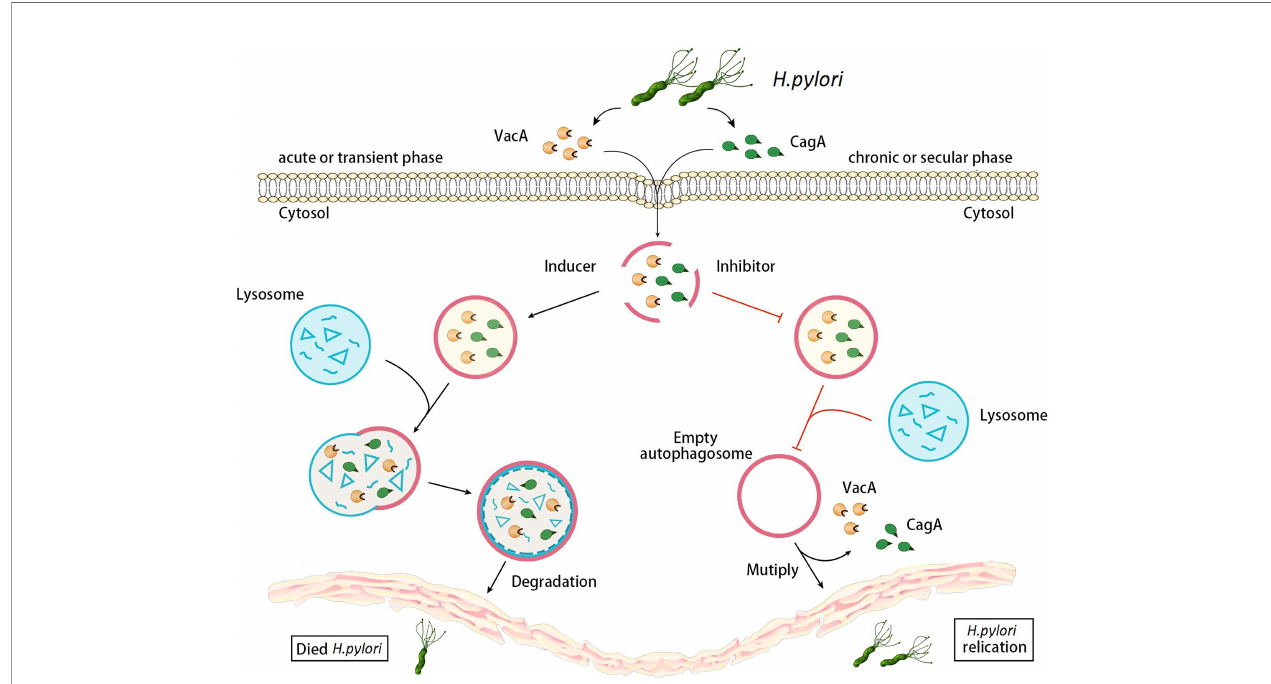
FIGURE 1 | Changes of autophagy in gastric epithelial cells during different stages of H. pylori infection. During the acute stage of H. pylori infection, VacA and CagA secreted by H. pylori infection induce autophagy, and then autophagy degrades VacA and CagA. However, during chronic H. pylori infections, VacA and CagA inhibit autophagy, limiting the degradation of VacA and causing the accumulation of autophagy substrates. Moreover, autophagy destruction of VacA leads to the reducing degradation of CagA, which further enhances damage to host